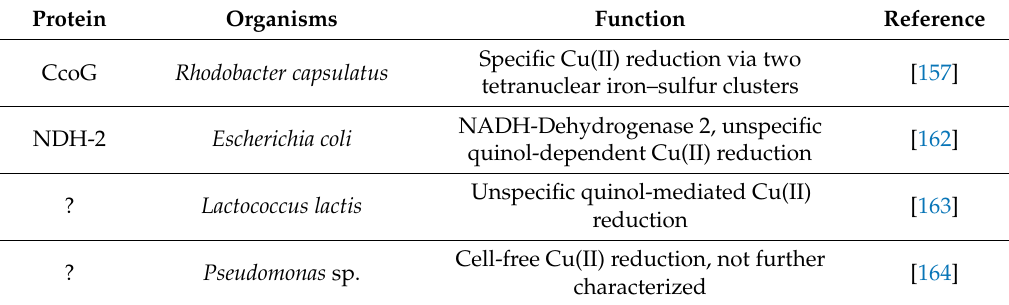
Table 2. Known bacterial cupric reductase